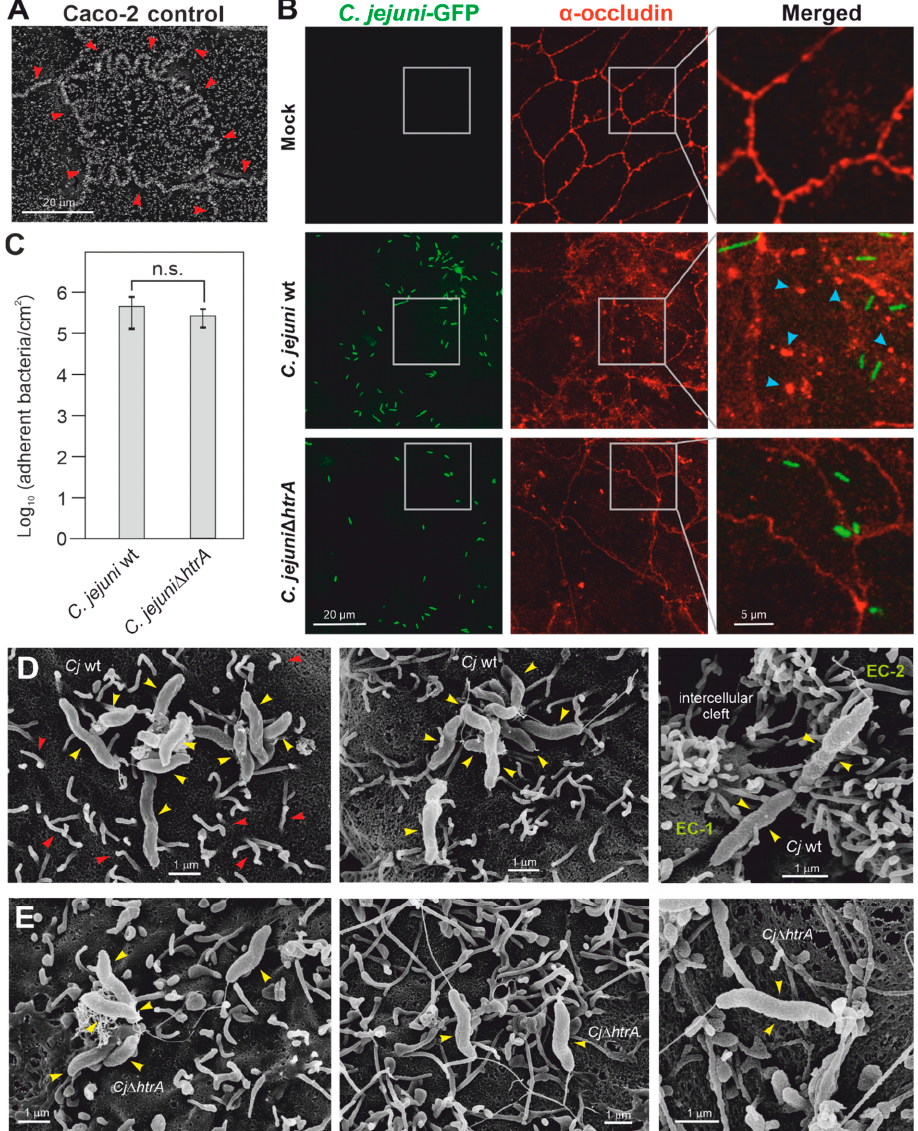
Figure 1. Scanning electron and fluorescence microscopy of Caco-2 cells before and after C. jejuni infection. ( A ) Top view of the apical surface of polarized Caco-2 cell monolayers without infection. Red arrowheads mark microvilli structures that are strongly expressed near the cell-to-cell junctions. ( B ) Fluorescence microscopy of Caco-2 cells counterstained with α -occludin (red), either as uninfected control ( top ), or infected with GFP-expressing wt bacteria ( middle ) or GFP-expressing ∆ htrA mutant ( bottom ). The cells were infected with an MOI of 10. Images with the merged C. jejuni and occludin staining ( right ) correspond to enlarged areas marked in the gray boxes. Blue arrowheads indicate examples of disrupted patches in the tight junctions. ( C ) Quantification of apical bound bacteria revealed no significant (n.s.) differences among the two strains. Scanning electron microscopy of Caco-2 cells after infection with C. jejuni wt ( D ) or ∆ htrA mutant ( E ). Attached C. jejuni bacteria are marked with yellow arrowheads and examples of microvilli with red arrowheads. Sporadically, infection with C. jejuni wt was seen with the local opening of cell-to-cell junctions visible as intercellular clefts formed at the apical cell surface between two neighboring epithelial cells (EC-1 and EC-2), as